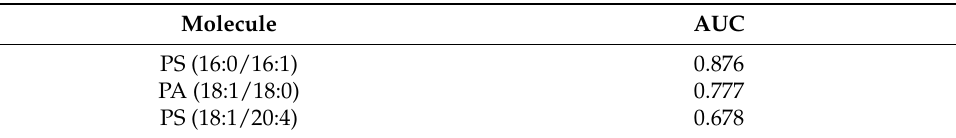
Table 3. The AUC values above 0.650 and the identification of molecules to be considered putative biomarkers differentiation between controls and MDD1 group (before treatment). Molecule